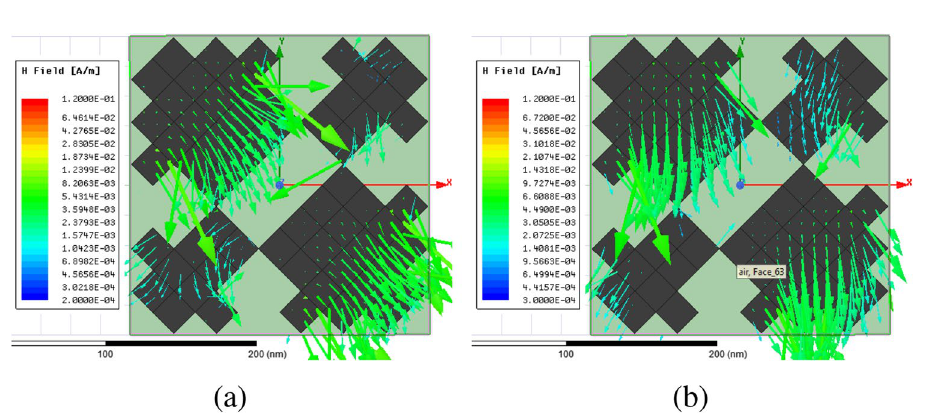
Figure 4. Magnetic field on the surface of the first structure ( a ) at 34.12 THz and ( b ) at 35.44. THz.